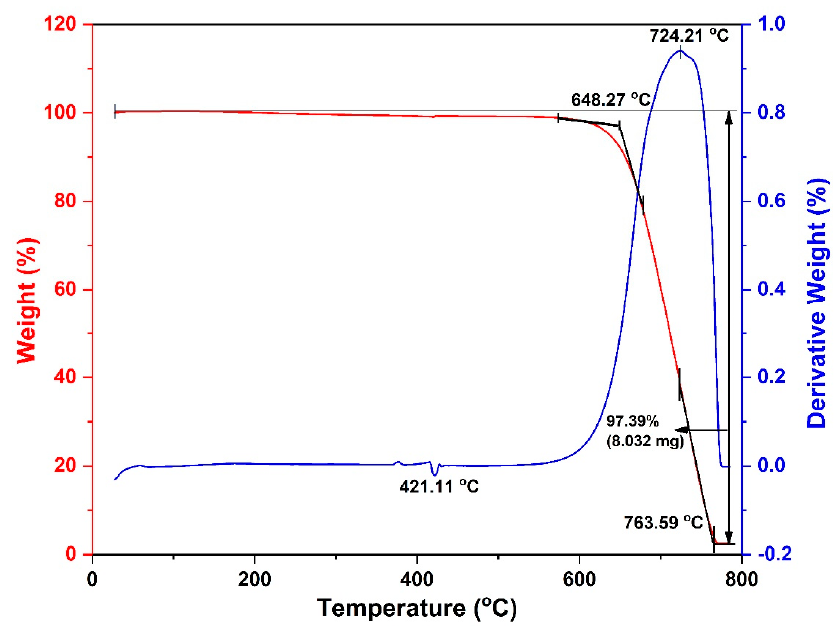
Figure 13. TGA curves of synthesized CNTs at the temperature of 850 °C.